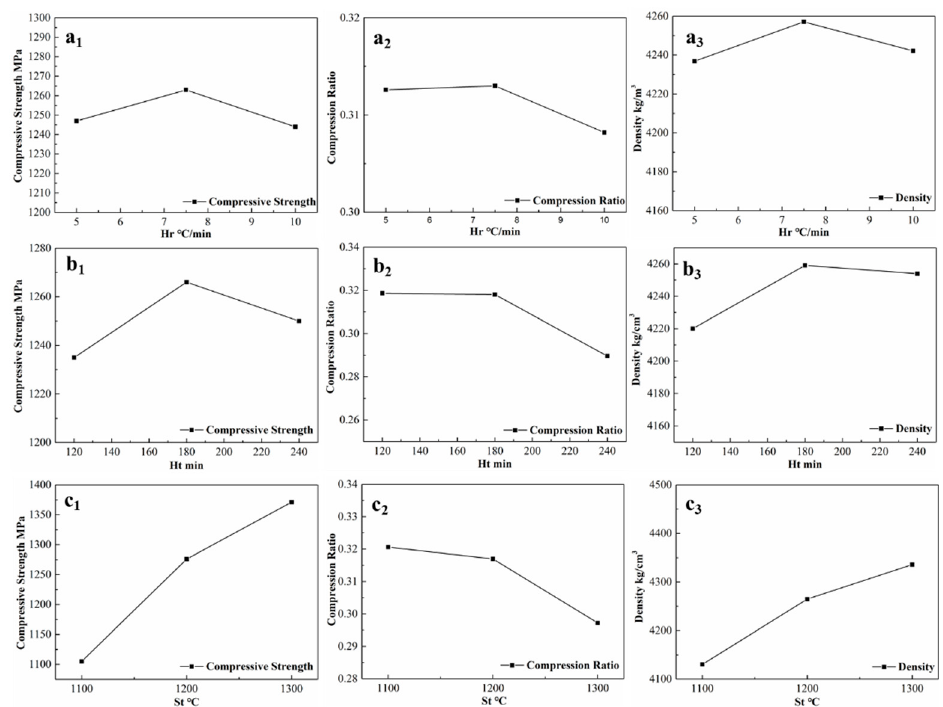
Figure 10. Main effect plots for ( a 1 ) Hr Vs. compressive strength; ( a 2 ) Hr Vs. compression ratio; ( a 3 ) Hr Vs. density; ( b 1 ) Ht Vs. compressive strength ( b 2 ) Ht Vs. compression ratio; ( b 3 ) Ht Vs. density; ( c 1 ) St Vs. compressive strength; ( c 2 ) St Vs. density; ( c 3 ) St Vs. compression ratio.